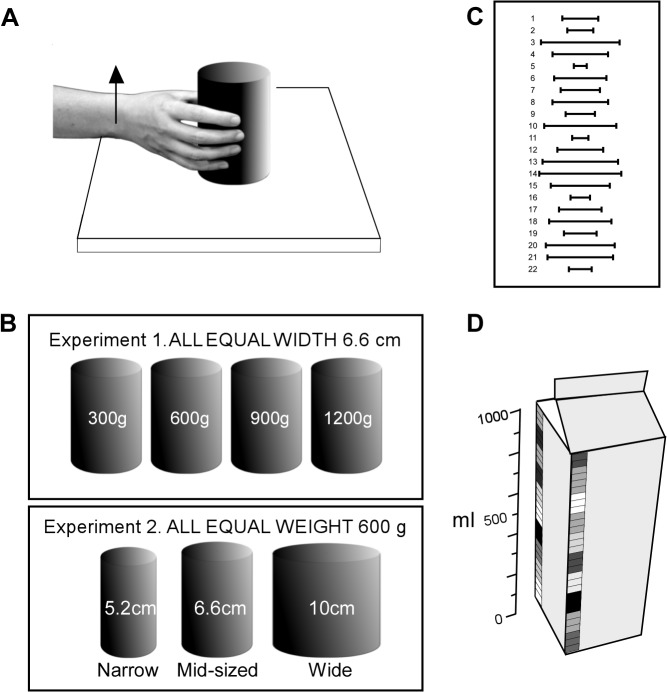
Experimental set-up.A, in both experiments 1 and 2, subjects grasped and lifted a range of standard cylindrical canisters of different weights and widths. The canisters were lifted with the right hand with movement at the wrist, elbow or shoulder. Throughout all experiments, the canisters and the subject’s arm were screened from view. B, shows the canisters of different dimensions lifted in both experiments. For experiment 1, the mid-sized test canisters (width 6.6 cm) were used to measure perceived horizontal spacing between the fingers and thumb (perceived grasp aperture) during a lift. These four test canisters ranged in weight from 300g–1200g. The narrow and wide canisters from experiment 2 each weighed 600g and were used as distractors (see Methods). For experiment 2, the test canisters included the narrow, mid-sized and wide canisters which each weighed 600g and ranged in size from 5.2cm–10cm. During the lift subjects reported the weight, they perceived to be lifting. Two mid-sized canisters from experiment 1 of 300 g and 900 g were used as distractors (see Methods). C, in experiment 1, subjects reported their perceived grasp aperture using an A3 sized visual chart with 22 numbered horizontal lines of different lengths that represented the grasp aperture of the hand. D, in experiment 2, subjects reported the weight of milk they perceived to be lifting using a coloured vertical scale marked on a one-litre carton with ten 1.9-cm coloured increments, each divided into upper, middle and lower portions for each colour. Each portion represented 33.3 g.